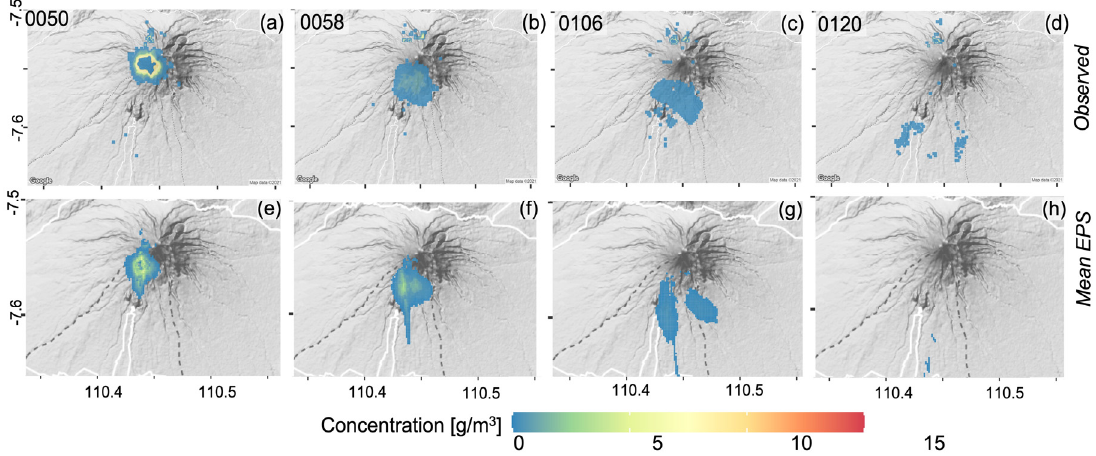
Figure 6. The retrieved tephra concentration on M05 based on valid Z H ( a – d ) compared with the mean EPS ( e – h ) at different time steps, as indicated in the top left corner. The mean EPS uses a threshold of tephra concentration ≥ 0.01 g/m 3 . In each image, the x -axis is longitude and y -axis is latitude.